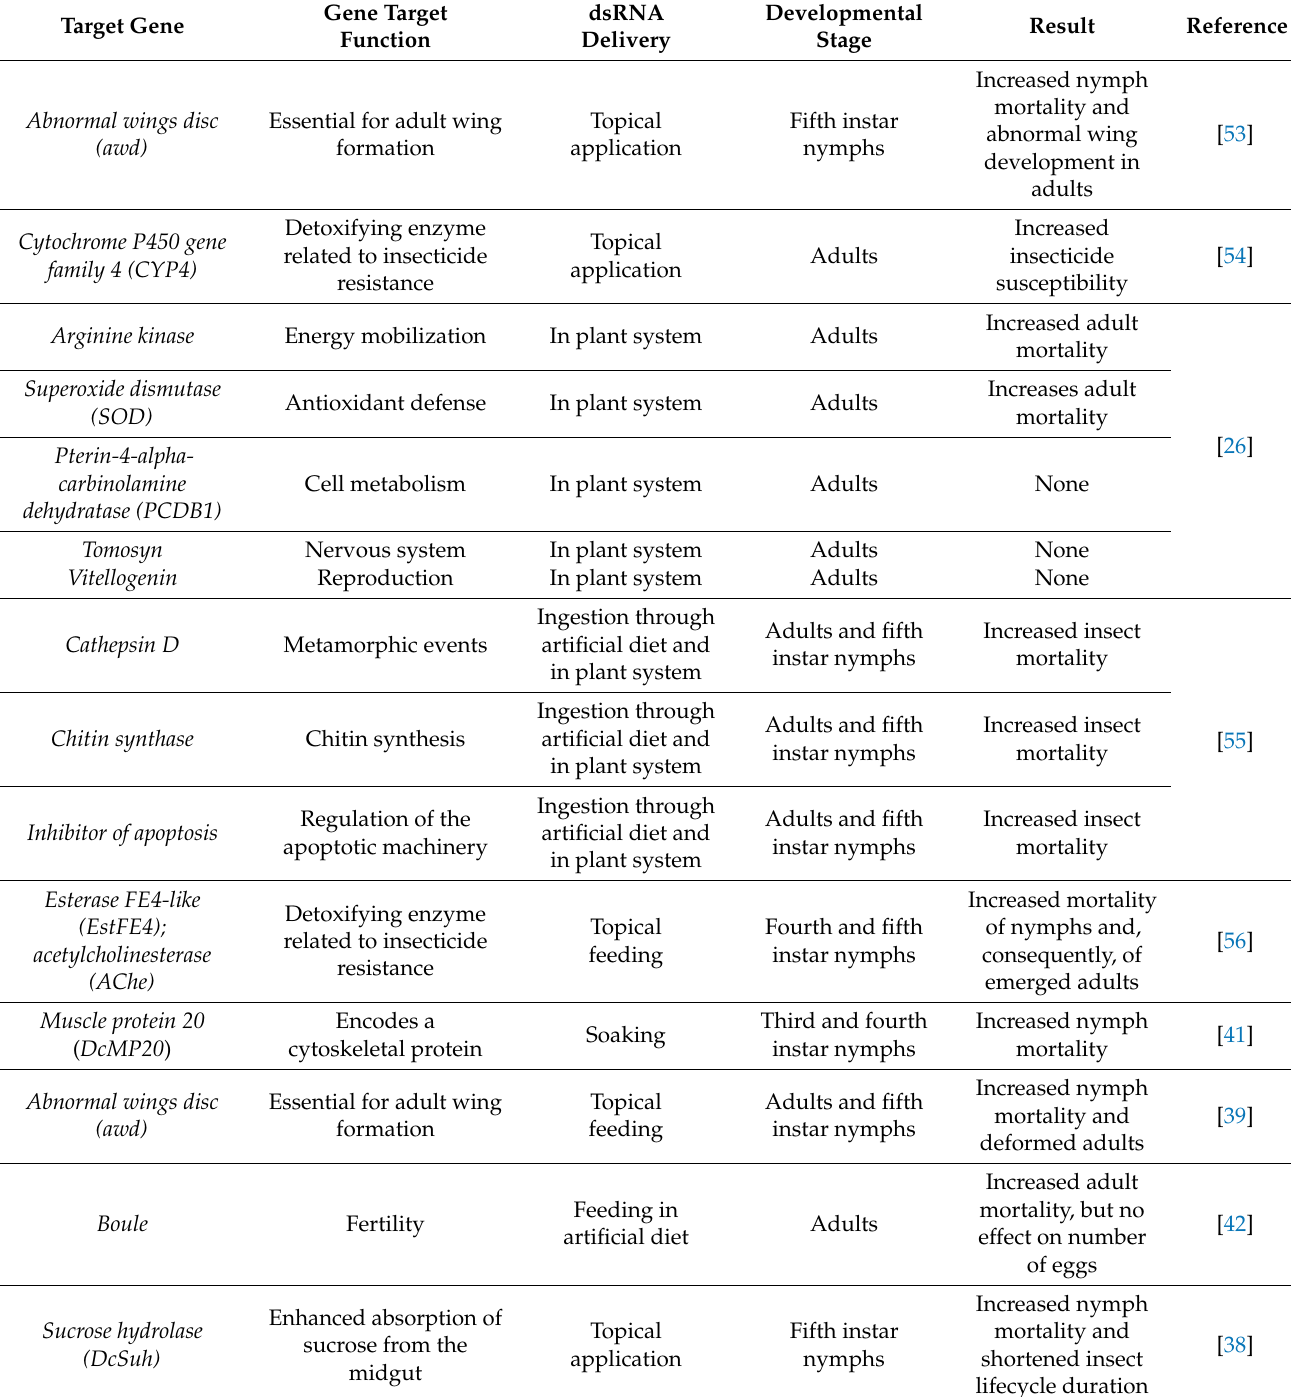
Table 1. Asian citrus psyllid (ACP, Diaphorina citri ) control via RNAi